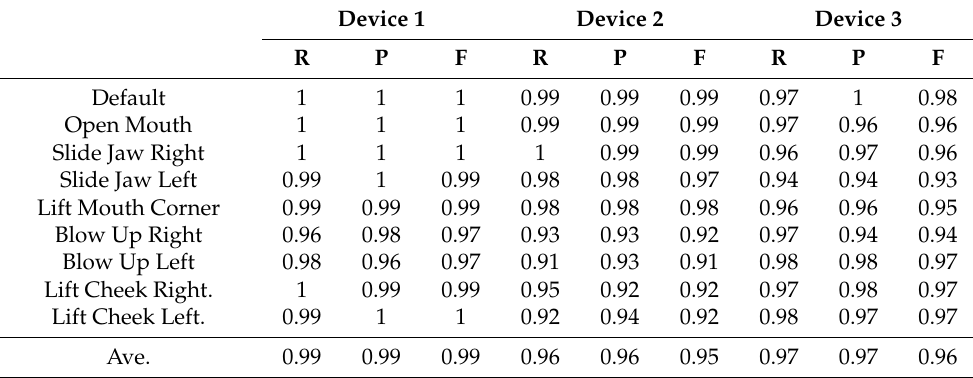
Table A1. The results of a single device for each gesture in Evaluation 1.